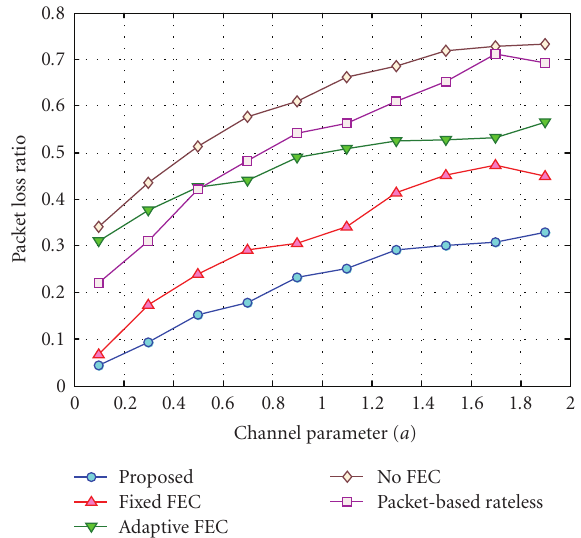
Figure 5: Packet loss ratio according to the number of redundant blocks in a Rayleigh channel with varying SNR.